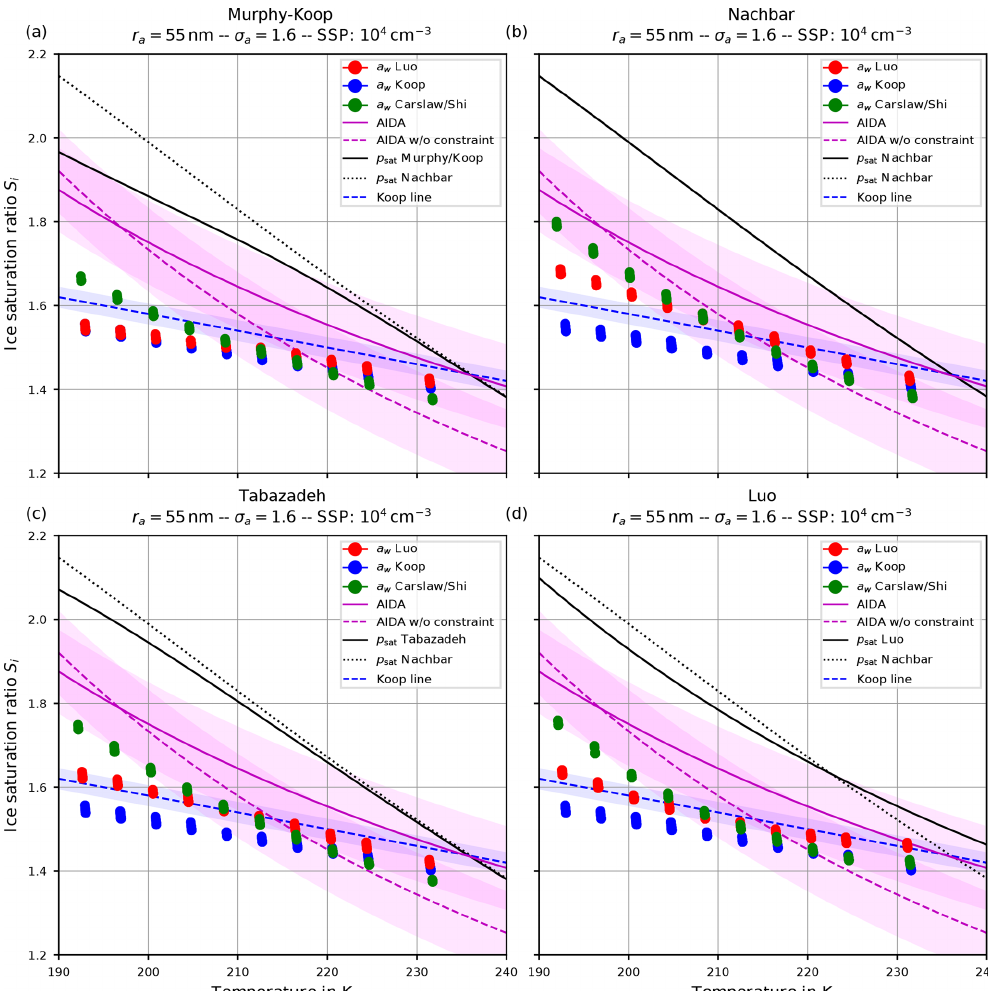
Figure 10. The same as in Fig. 9 but with the choice σ a = 1 . 6 for the dry aerosol lognormal size